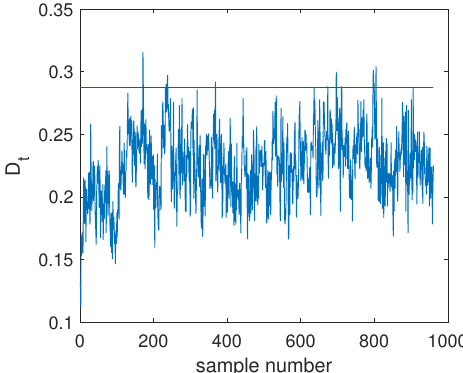
Figure 8. Fault detection chart of fault F19 based on SVDD.